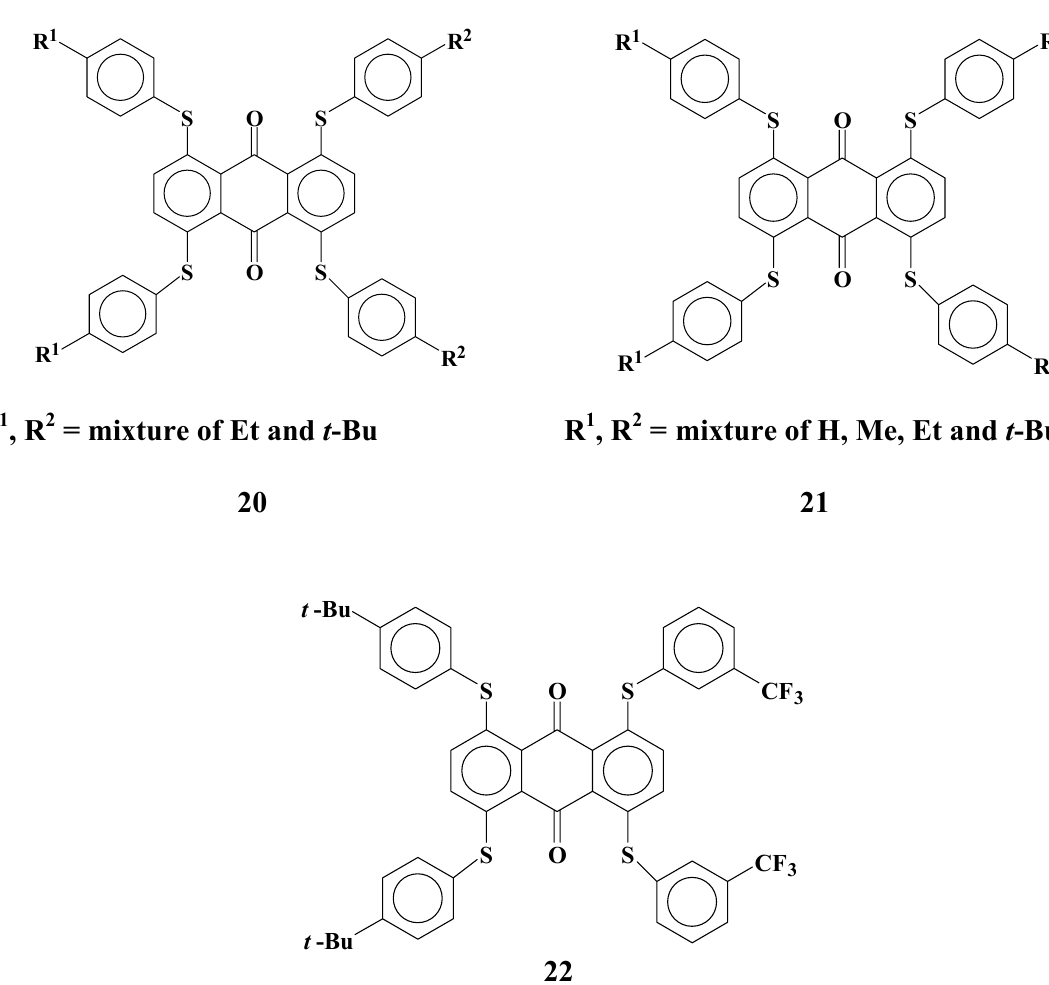
Figure 13. The molecular structures of magenta dichroic dyes with phenylthio groups at the 1, 4, 5 and 8 positions.